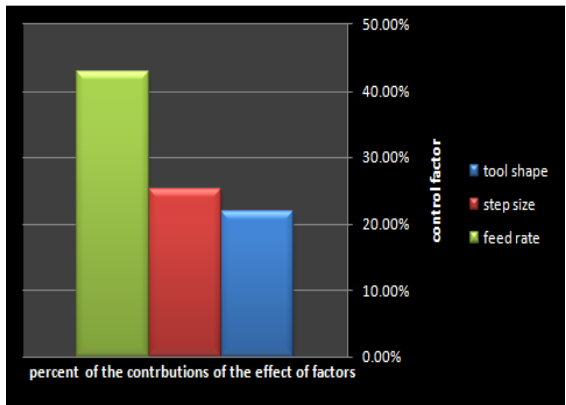
Fig. 15. Percentage contributions of means (55 ◦ wall angle).